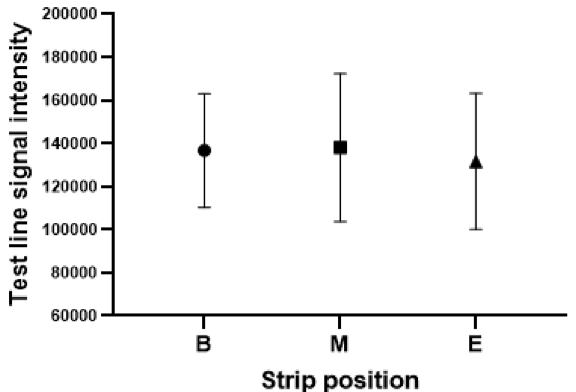
Figure 3. SARS-CoV-2 RDT cassette intra-lot reproducibility. Interval plot of RDS-2500 test line signal intensity vs. beginning (B), middle (M), or end (E) strip location using 2.5 ng/mL recombinant